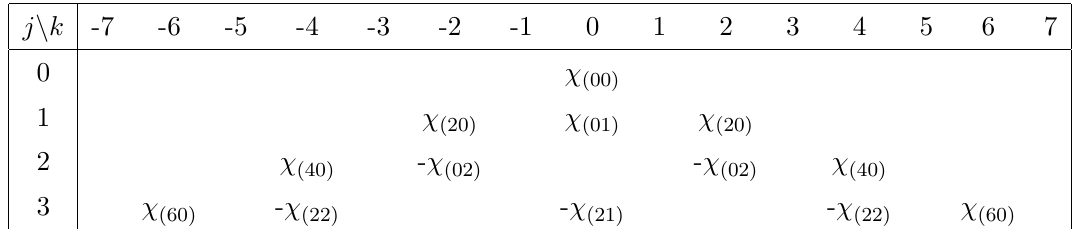
Table 12. Nonvanishing coe(cid:14)cients a (1)